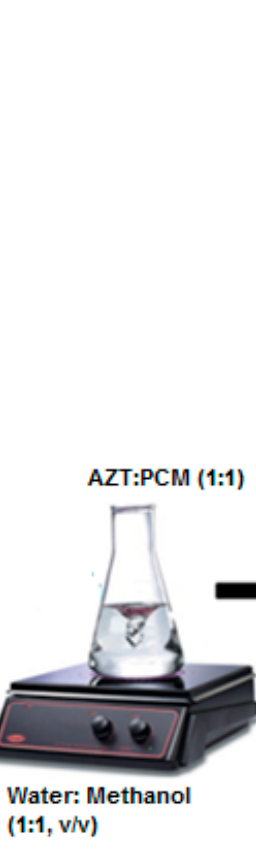
Figure 2. Scheme of study for synthesis, characterization and in vitro evaluation of cocrystal.